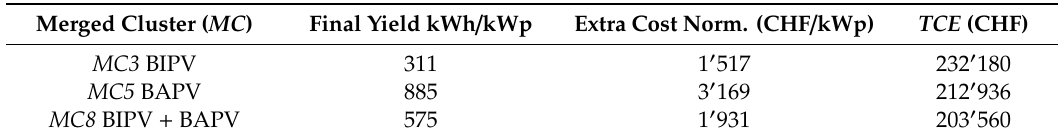
Table 5. Comparison between BIPV and